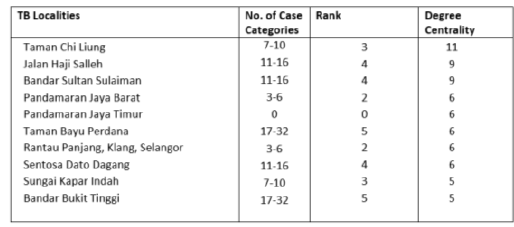
Table 2. Comparison between Rank and Degree